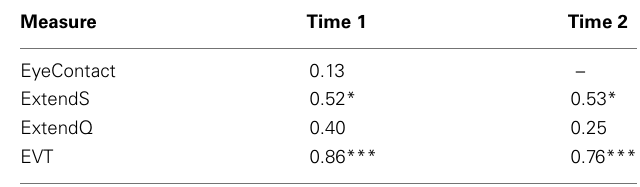
Time 1: Non-verbal intellectual ability: DAS Nonverbal cluster SS, Expressive vocabulary ability: EVT SS. Time 2: Non-verbal intellectual ability: DAS-II